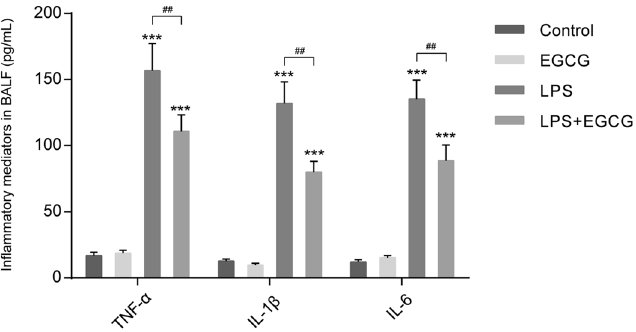
Figure 2. EGCG decreases the levels of the inflammatory cytokines in vivo. The BALF levels of inflammatory factors, including TNF-α, IL-6, and IL-1β in each group were examined by ELISA using corresponding mouse ELISA kits. *** P < 0.001 compared to Control group; ## P < 0.001 compared to LPS group.